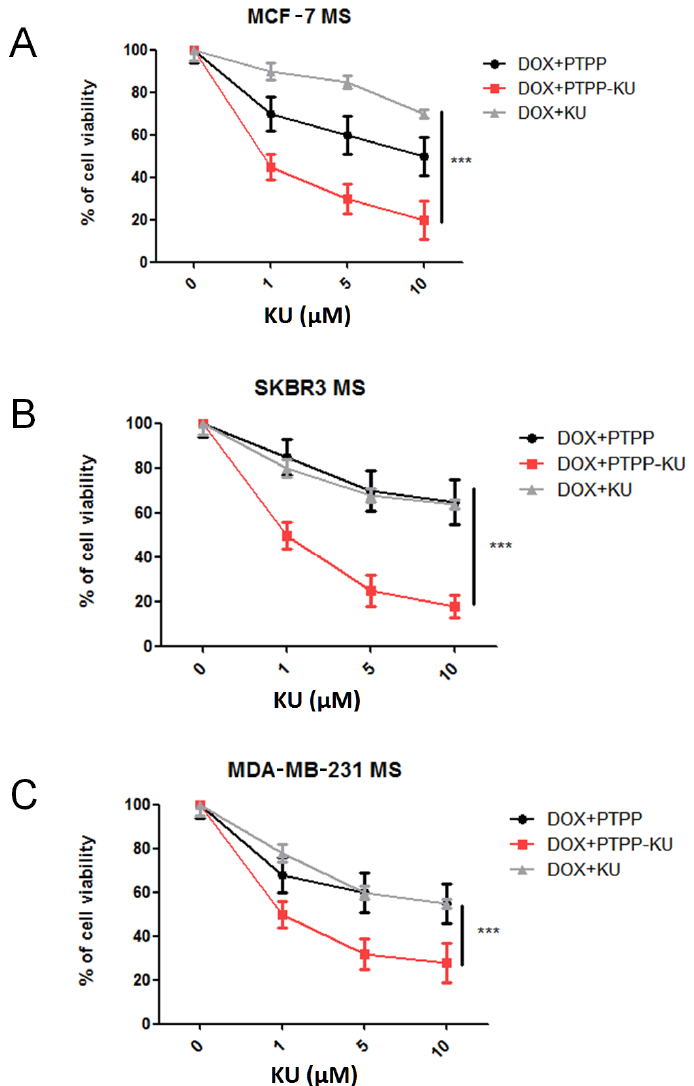
Figure 5. PTPP–KU sensitizes p53 WT and mutant p53 mammospheres to DOX. Cell viability of ( A ) MCF-7, ( B ) SKBR3 and ( C ) MDA-MB-231 cell lines grown in mammosphere (MS) conditions. Cells were treated with 1 µ M of Doxorubicin (DOX) for 3 hours with increased concentrations of free KU-55933 (KU), PTPP–KU, and PTPP (administered 30 min before adding DOX), as indicated (the corresponding PTPP concentrations were 1 µ g/mL, 5 µ g/mL, and 10 µ g/mL, respectively). After 24 h, cell viability was measured using an MTS assay. The results are expressed as the mean ± SD for at least three independent experiments and were analyzed using a Student’s t -test (*** p < 0.001) ( n = 6).